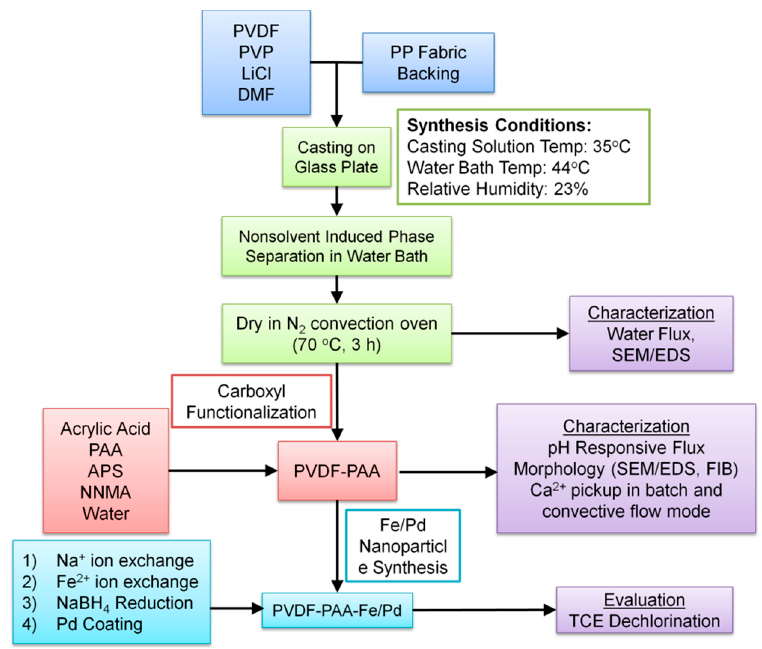
Figure 1. Flowchart detailing spongy membrane synthesis, functionalization, and characterization procedure.